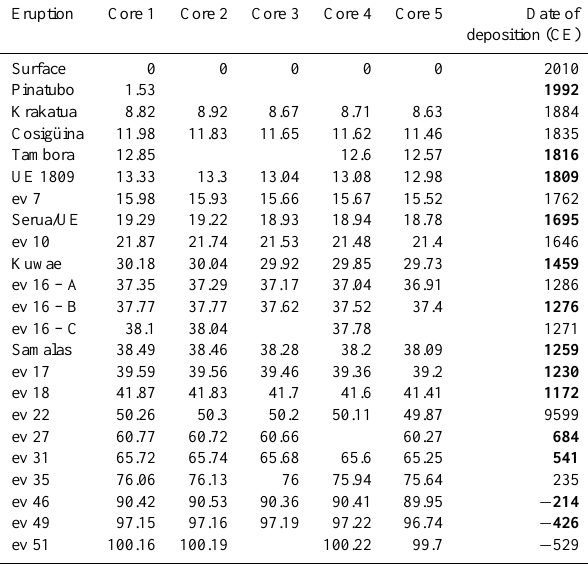
Table 1. Tie points used to set the timescale and synchronize the cores. Volcanic events are named “ev x ” if they are not assigned to a well-known eruption. Dating of the events is based on Sigl et al. (2015) and is given as CE dates, with negative figures referring to dates BCE. Eruption